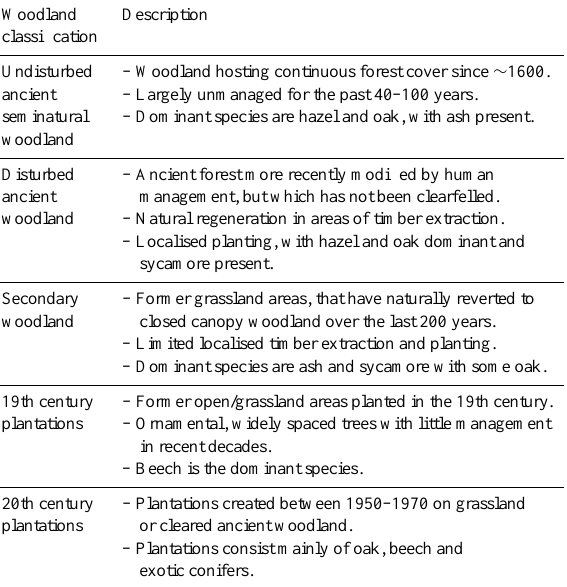
Table 1. Classification of woodland in terms of management history at Wytham (adapted from Morecroft et al.,